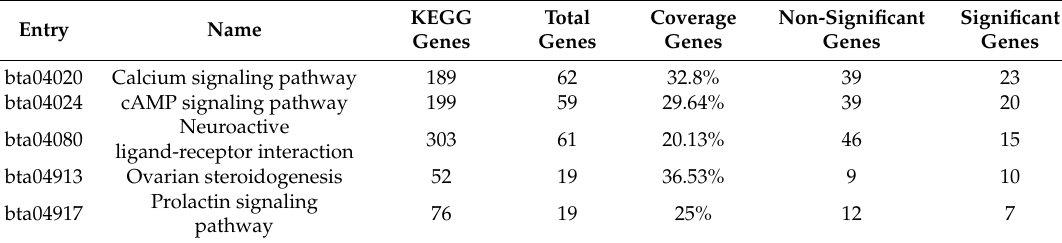
Table 1. Molecular interactions and reaction networks from the KEGG Pathway Database where genes FSHR and LHCGR are involved. Entry column corresponds to the id. Name column is the process to which it belongs. KEGG genes column is the number of genes that interact in the network. Total genes column is the number of genes that had at least 15 SNPs. Coverage genes column is the percentage of genes found in KEGG. Non-significant genes column is the number of genes that failed the Benjamini-Hochberg adjustment test. The Significant genes column is the number of genes that passed the